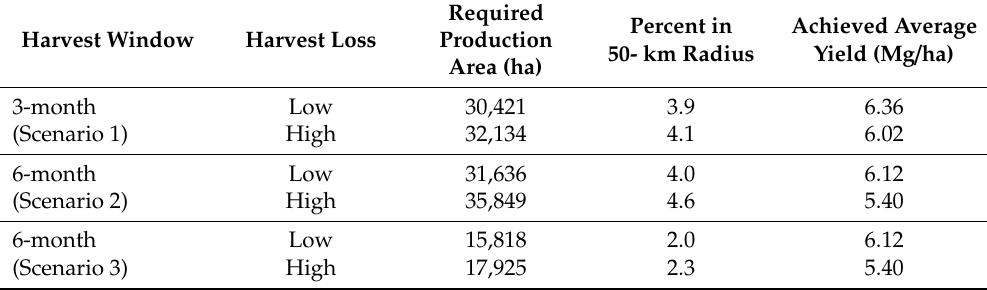
Table 3. Required production area (accounting for harvest loss) and achieved average yield across entire production area. (Results obtained with Scenarios 1, 2, and 3 MATLAB